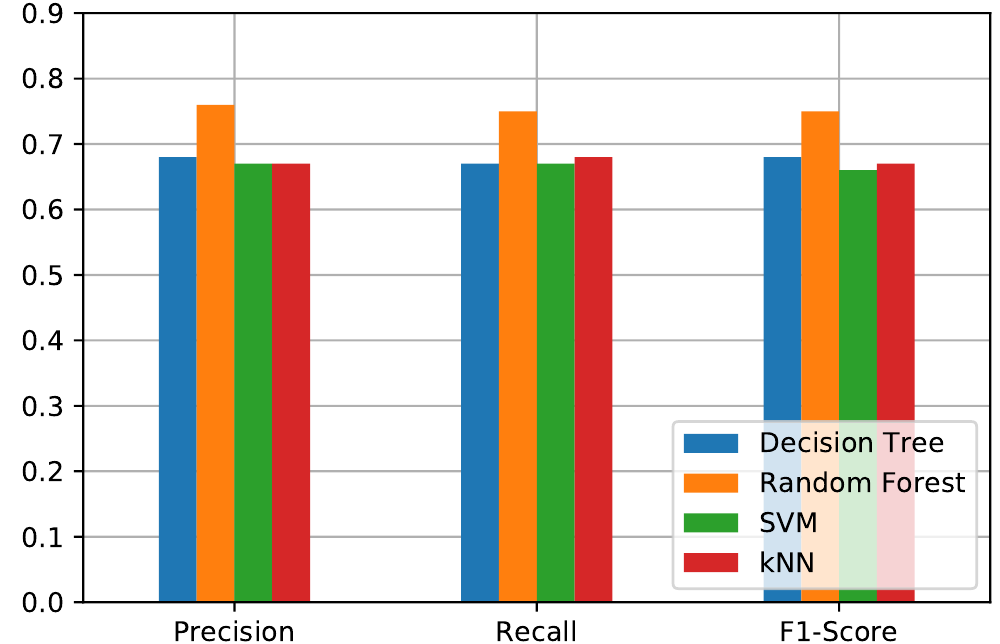
Figure 12. Q4—Precision, Recall, and F1-Score to predict the number of